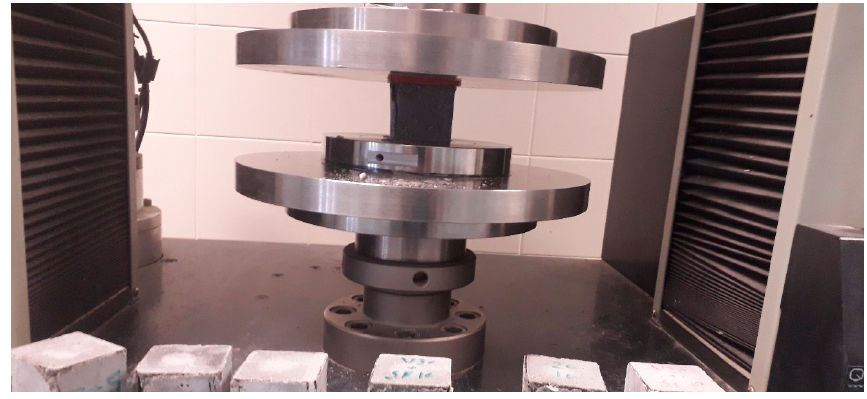
Figure 3. Test set up used to perform compressive strength tests on mortar cubes.